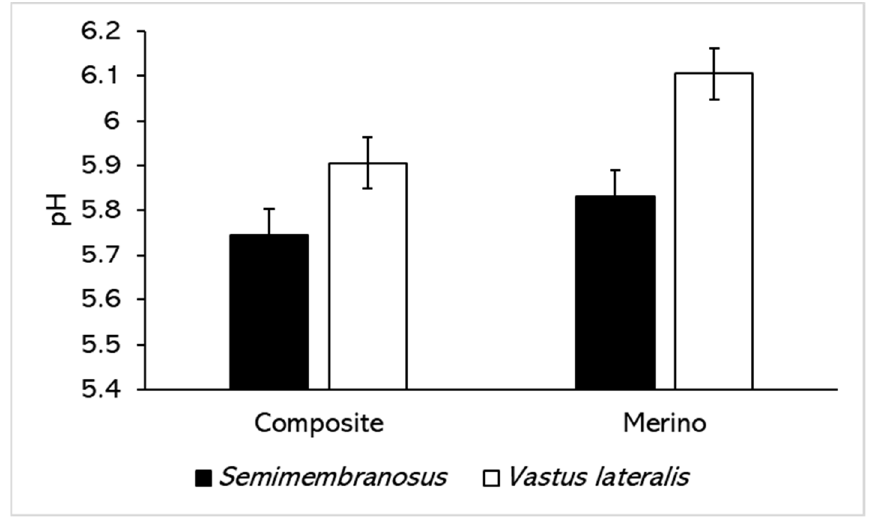
Figure 1. The pH of Semimembranosus and Vastus lateralis from Composite and Merino sheep before retail packaging. Values are predicted means ± standard error of differences (SED). p (breed × muscle) is 0.096.